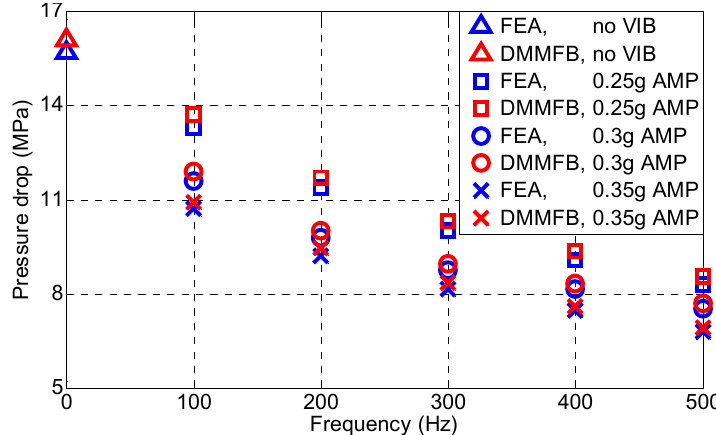
Figure 7. Effective value of the internal pressure drop inside the extrusion liquefier without and with different-amplitude vibration applied.